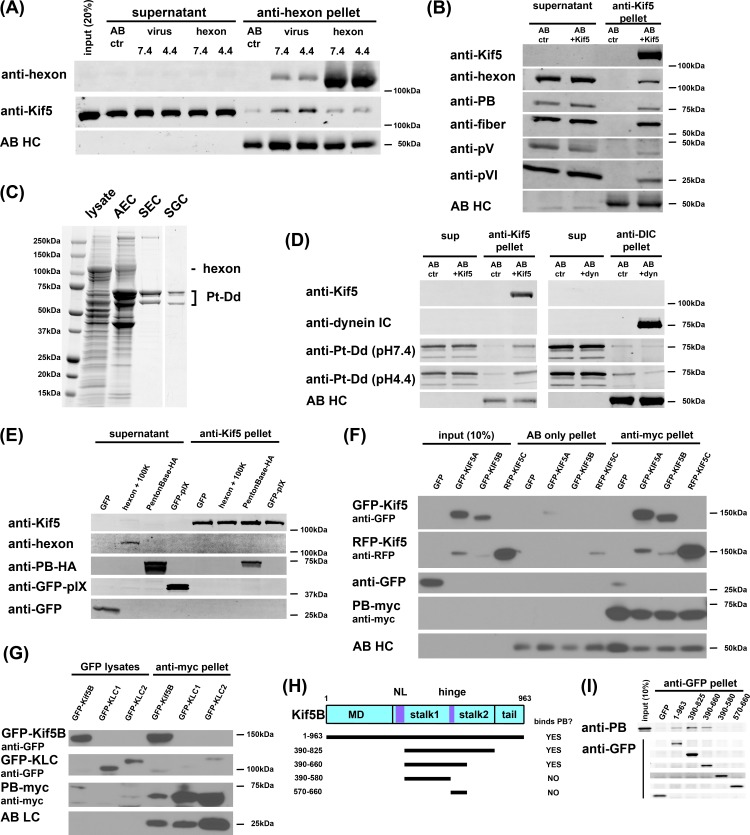
Interaction between adenovirus and kinesin-1.(A) Immunoisolated Ad5 capsids or hexon alone were transiently exposed to pH7.4 or 4.4 buffer, and then incubated at pH 7.4 with a rat brain kinesin fraction. Kinesin-1 heavy chain (Kif5) coimmunoprecitated with adenovirus capsids, but not with hexon alone, and independent of pH. AB HC: antibody heavy chain. (B) Coimmunoprecipitation of Ad5 capsids with kinesin-1, isolated from brain kinesin fraction using H2 monoclonal antibody. Capsid components in immunoprecipitate included penton base, PB: protein V, pVI: protein VI. (C) Purification of Ad5 penton-dodecahedra (Pt-Dd) from infected 293A cell lysate, stained with Coomassie blue, show preparation following anion exchange chromatography (AEC), size exclusion chromatography (SEC), and sucrose gradient centrifugation (SGC). (D) Immunoisolated kinesin-1 (MAB1614) but not cytoplasmic dynein (MAB1618) pulled-down purified Pt-Dd, independent of Pt-Dd exposure to low pH. (E) Immunoisolated kinesin-1 (MAB1614) pull-down recombinant penton base, but not hexon, pIX or GFP expressed in 293A cells for 24h. (F) Penton-base pull-down of kinesin. Myc-tagged penton base was coexpressed with GFP, GFP-Kif5A, GFP-Kif5B, and RFP-Kif5C in 293A cells for 24h and lysates were subjected to anti-myc immunoprecipitation. All three Kif5 isoforms coimmunoprecipitated with myc-penton base to similar levels. (G) GFP-tagged Kif5B heavy chain and the kinesin light chains KLC1 and KLC2 were coexpressed with penton base-myc in 293A cells for 24h and lysates were subjected to anti-GFP immunoprecipitation. Penton base coimmunoprecipitated with Kif5B, but neither kinesin light chain. (H) Schematic representation of the KHC (KIF5B) polypeptide and summary of the penton base binding result (data in panel I). Penton base bound Kif5B constructs, which contain the central hinge region between stalk 1 and stalk 2. MD: motor domain, NL: neck linker. (I) GFP-Kif5B truncation constructs were expressed in 293A cells and lysates were subjected to anti-GFP immunoprecipitation. Upon addition of purified Pt-Dd, binding was assessed by Western blotting with anti-GFP and anti-PB antibodies.